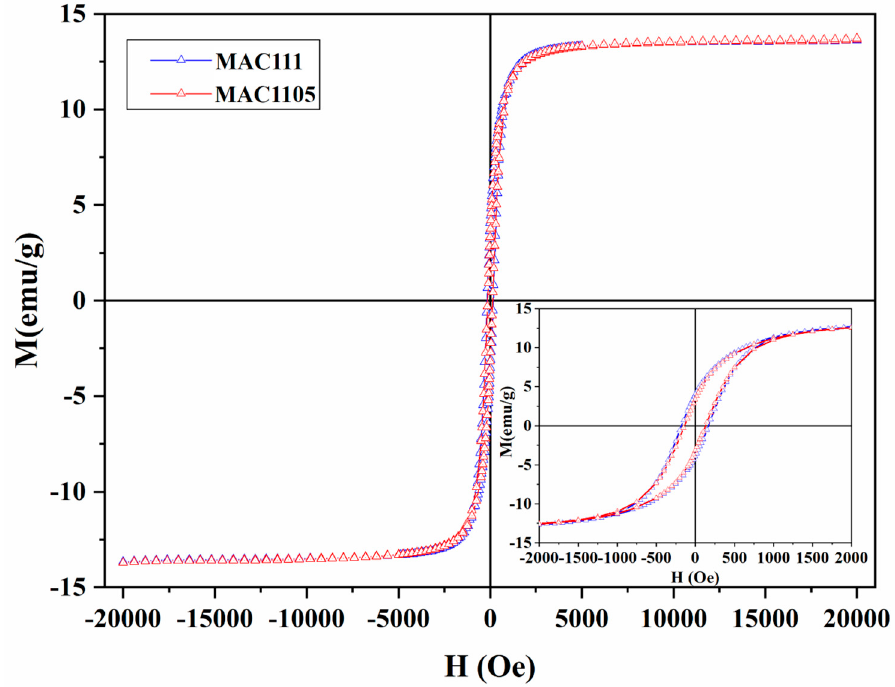
Table 2. Magnetic properties of the magnetic activated carbons.